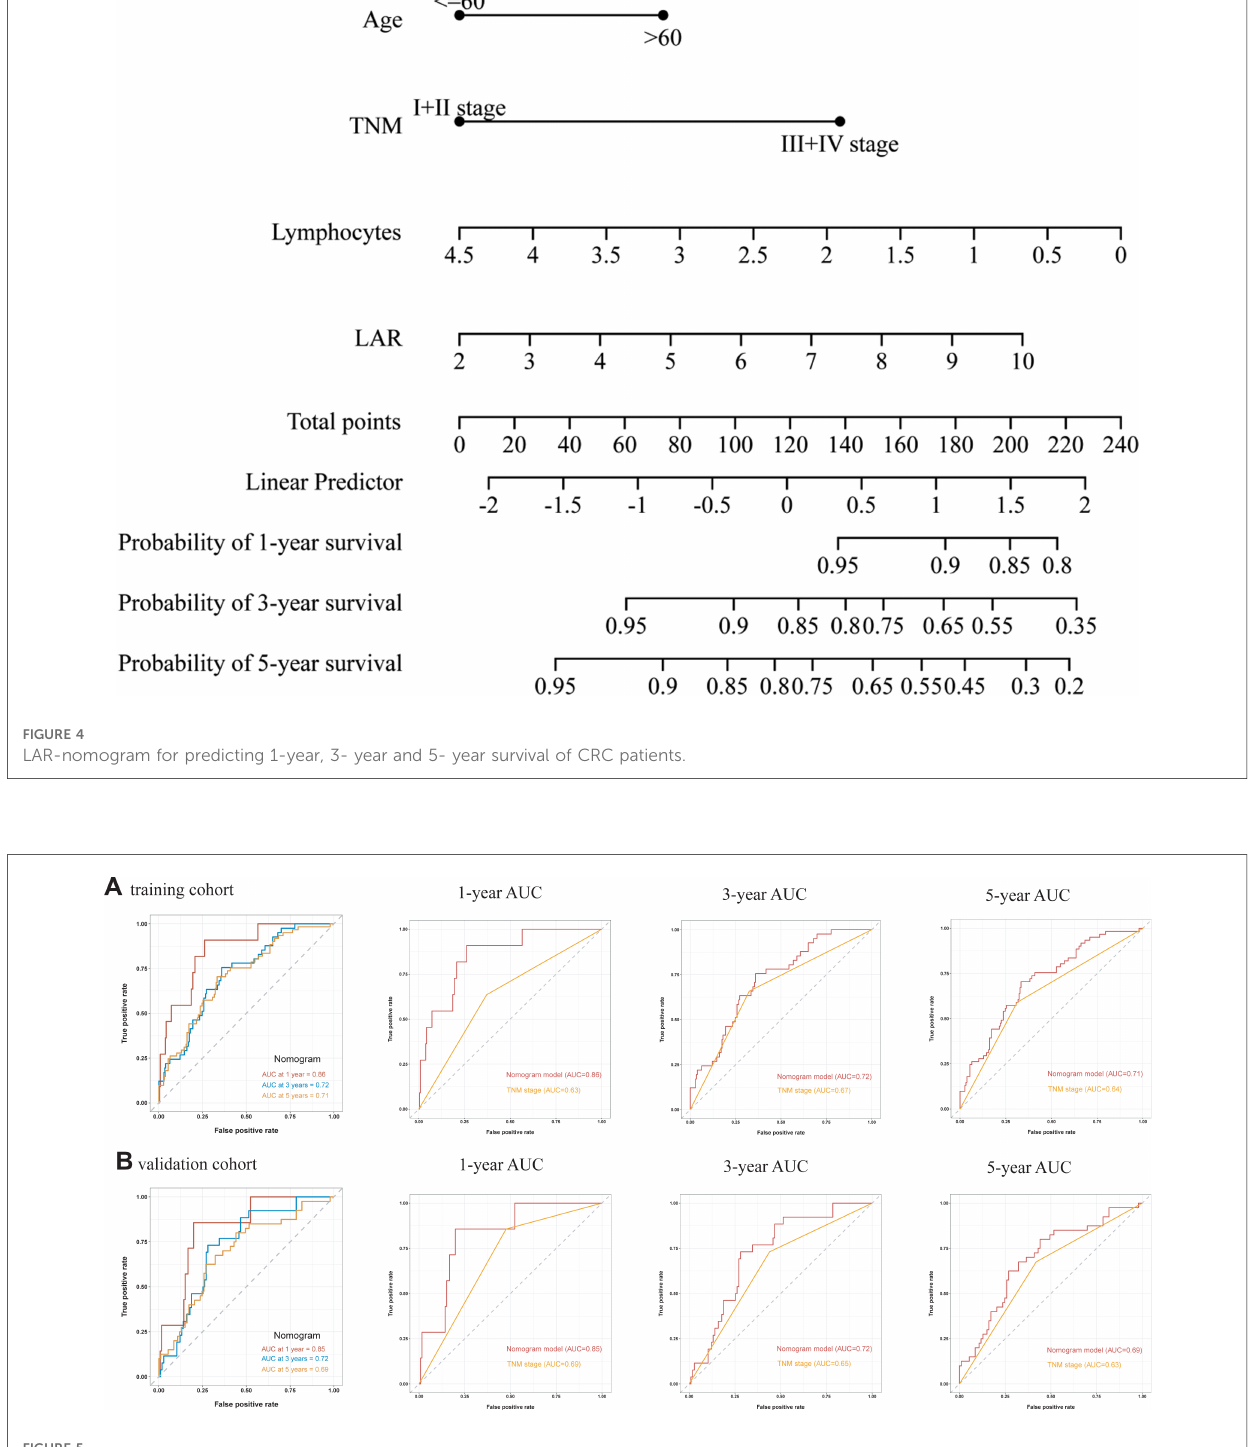
FIGURE 5 Time-independent ROC curves of the LAR-nomogram and TNM stage for 1-year, 3-year and 5-year survival